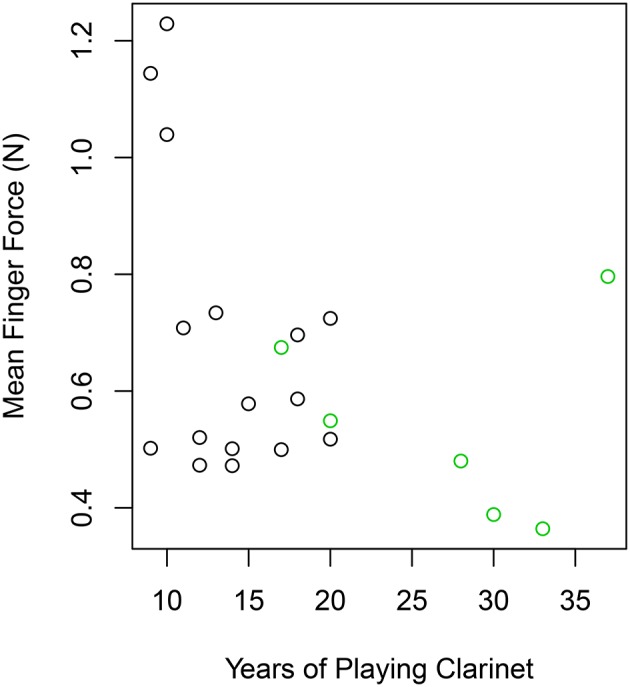
Mean finger forces (Fmean) per participant measured during the technical exercise task in comparison to the experience in clarinet playing in years (green = professionals, black = students).